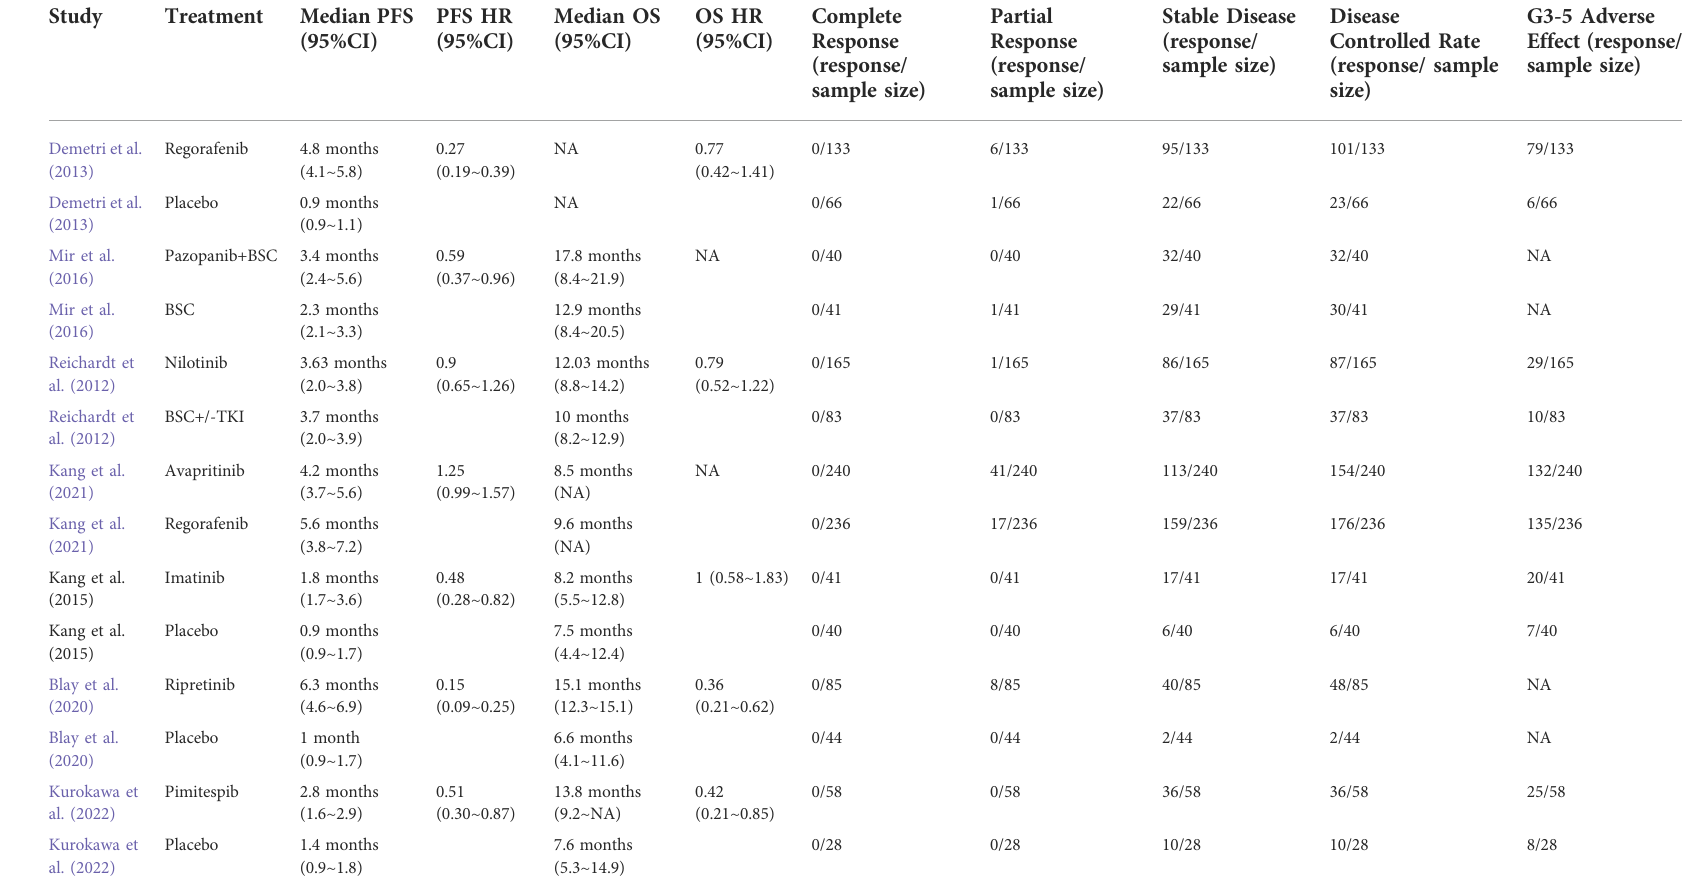
TABLE 2 Ef fi cacy and safety data of included